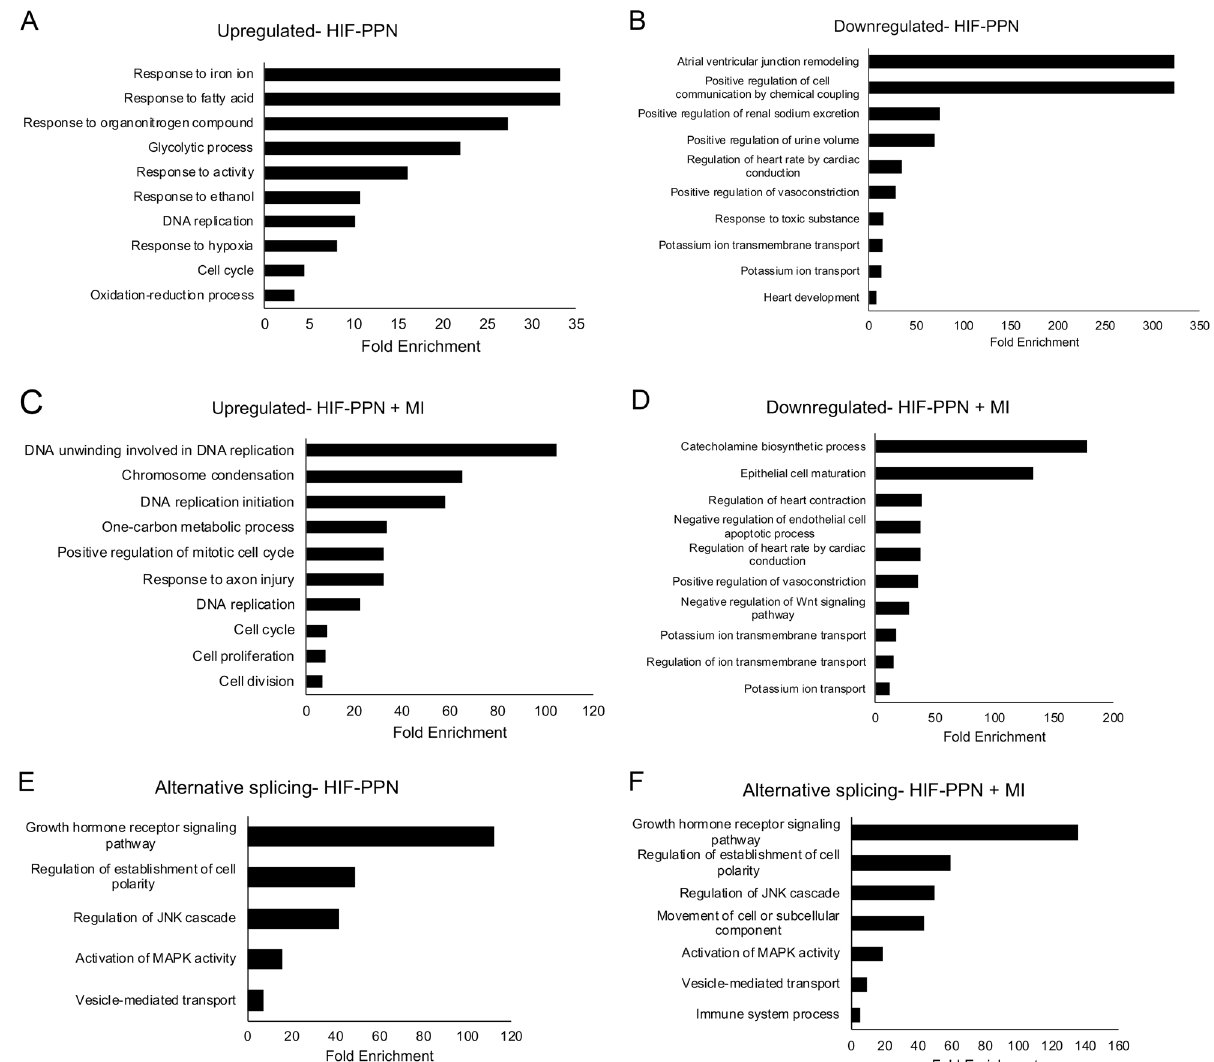
Figure 1. DAVID analysis of differentially expressed genes (DEGs) in HIF-PPN hearts. ( A , B ) Both up- ( A ) and downregulated DEGs ( B ) by log 2 (fold change) ≥ 1 or ≤ − 1 3 days after HIF-PPN induction were analyzed by DAVID to find most dysregulated pathways using gene ontology (GO) terms for biological process. ( C , D ) GO enrichment for genes upregulated ( C ) and downregulated ( D ) by at least log 2 (fold change) ≥ 1 or ≤ − 1 in both HIF-PPN and post-MI hearts. ( E , F ) Enriched GO terms for alternatively spliced genes in HIF-PPN hearts ( E ) and HIF-PPN plus post-MI hearts ( F ) were analyzed using the same method. Bar graphs show top GO terms as ranked by P -value (or EASE score, determined by modified exact Fisher’s test) as well as fold enrichment for each term. All P <